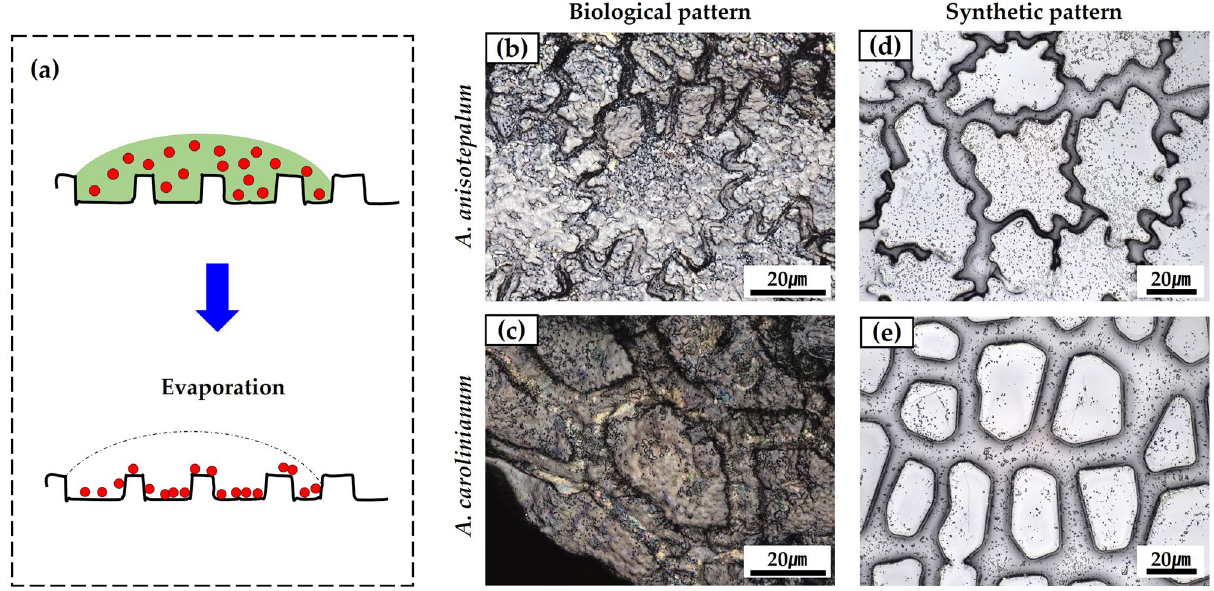
Figure 4. ( a ) Schematics for particle residues on hydrophilic surfaces. Particle aggregation patterns on ( b , c ) biological and ( d , e ) synthetic seed surfaces after drying sprayed droplets of particle-laden